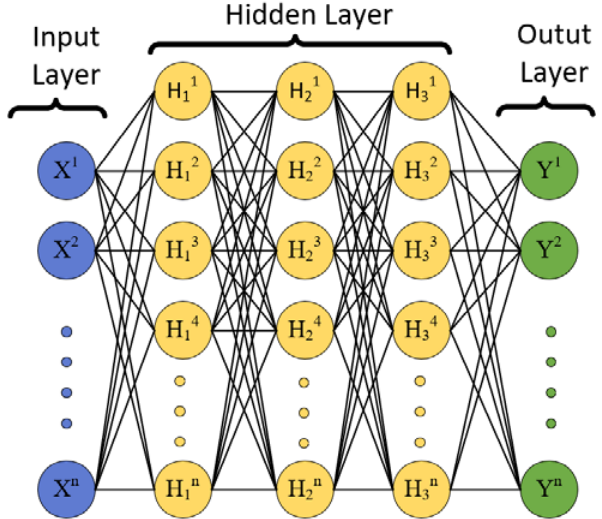
Figure 3. A simple ANN architecture.